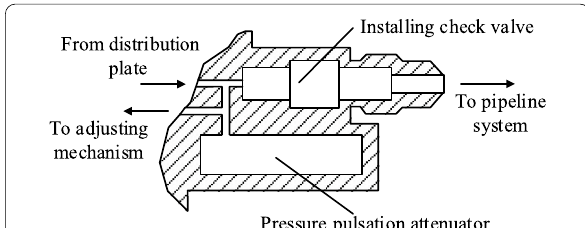
Figure 6 Partial sectional view of pressure pulsation attenuator in pump body